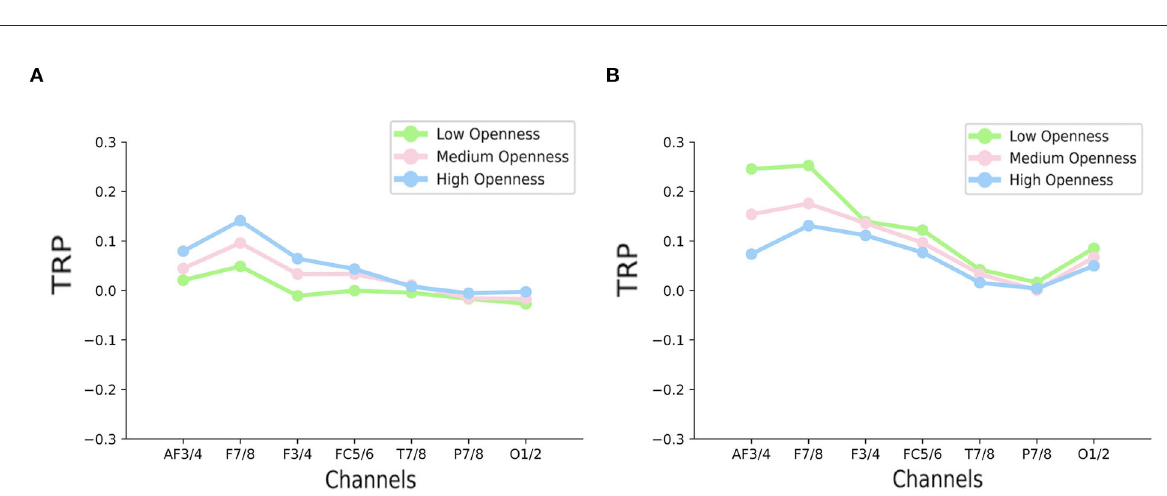
and an F1 score of 85.8%. Meanwhile, Spike-EEGNet achieved a recognition accuracy of 92.2%, a precision of 87.4%, a recall of 89.6%, and an F1 score of 88.5%. Spike- EEGNet achieved a better performance on all